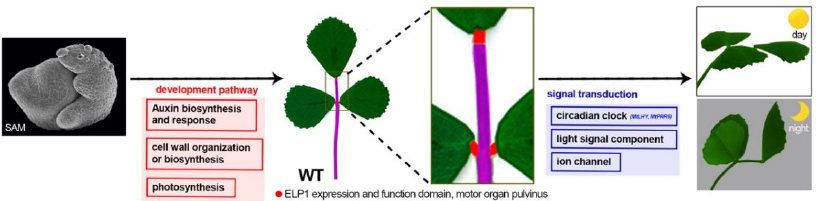
Figure 8. Schematic model for gene regulatory landscape of pulvinus development and signal transduction. The compound leaf consists of leaflets, pulvinus and petiole, and they initiate from the shoot apical meristem. During the pulvinus development process, the auxin biosynthesis and signal, cell wall and chloroplast ‐ related genes are involved. At latter mature pulvinus stage, the circadian clock, light signal and ion channel ‐ related genes participate in nyctinastic leaf movement regulation.